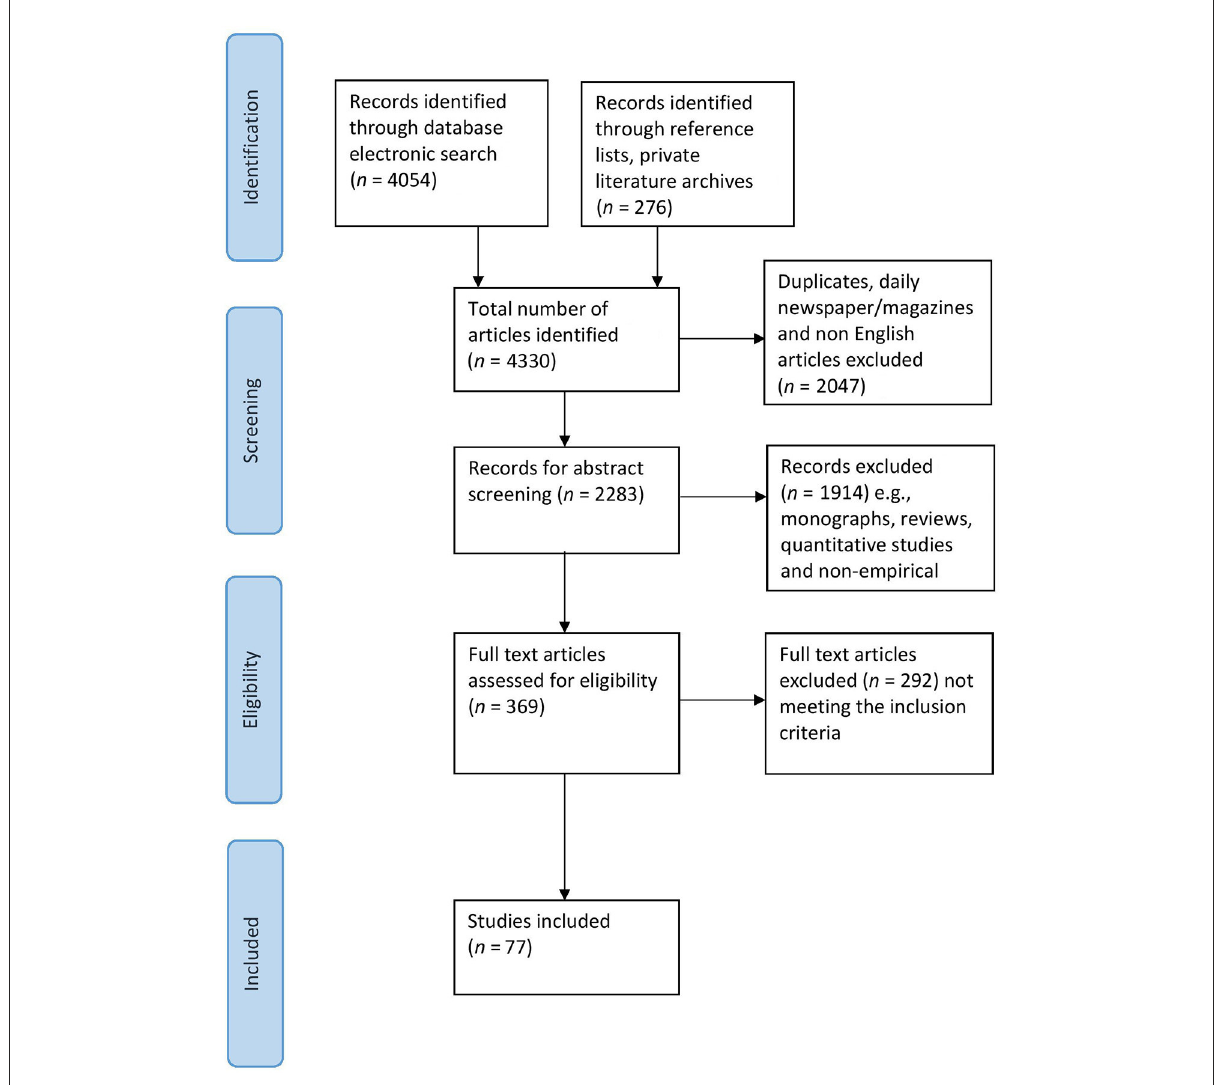
FIGURE1 PRISMA flow